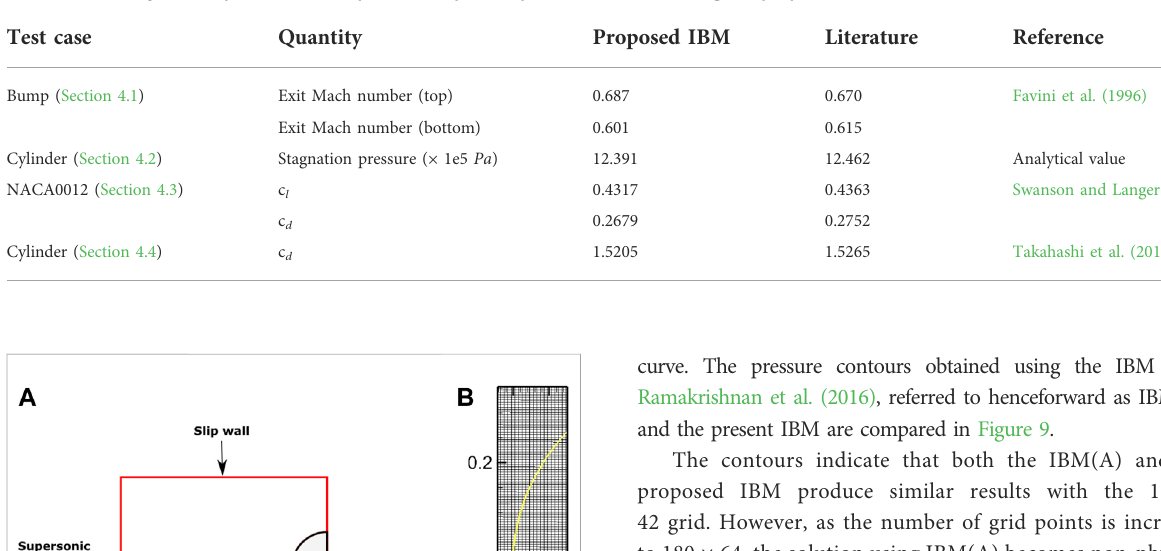
TABLE 2 Summary of the quantitative comparison of speci fi c quantities obtained using the proposed IBM with the literature.